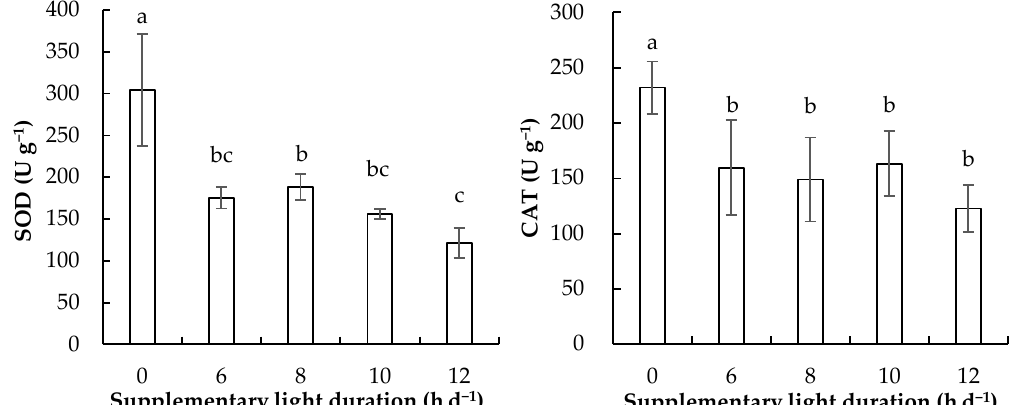
Figure 5. Effects of supplementary light duration with the same daily light integral on the activities of superoxide dismutase (SOD) and catalase (CAT) of cucumber seedlings grown in the greenhouse for 21 days after sowing. Means followed by different letters within each parameter are significantly different based on the least significant difference (LSD) test ( p < 0.05). Error bars show mean ± standard deviation.